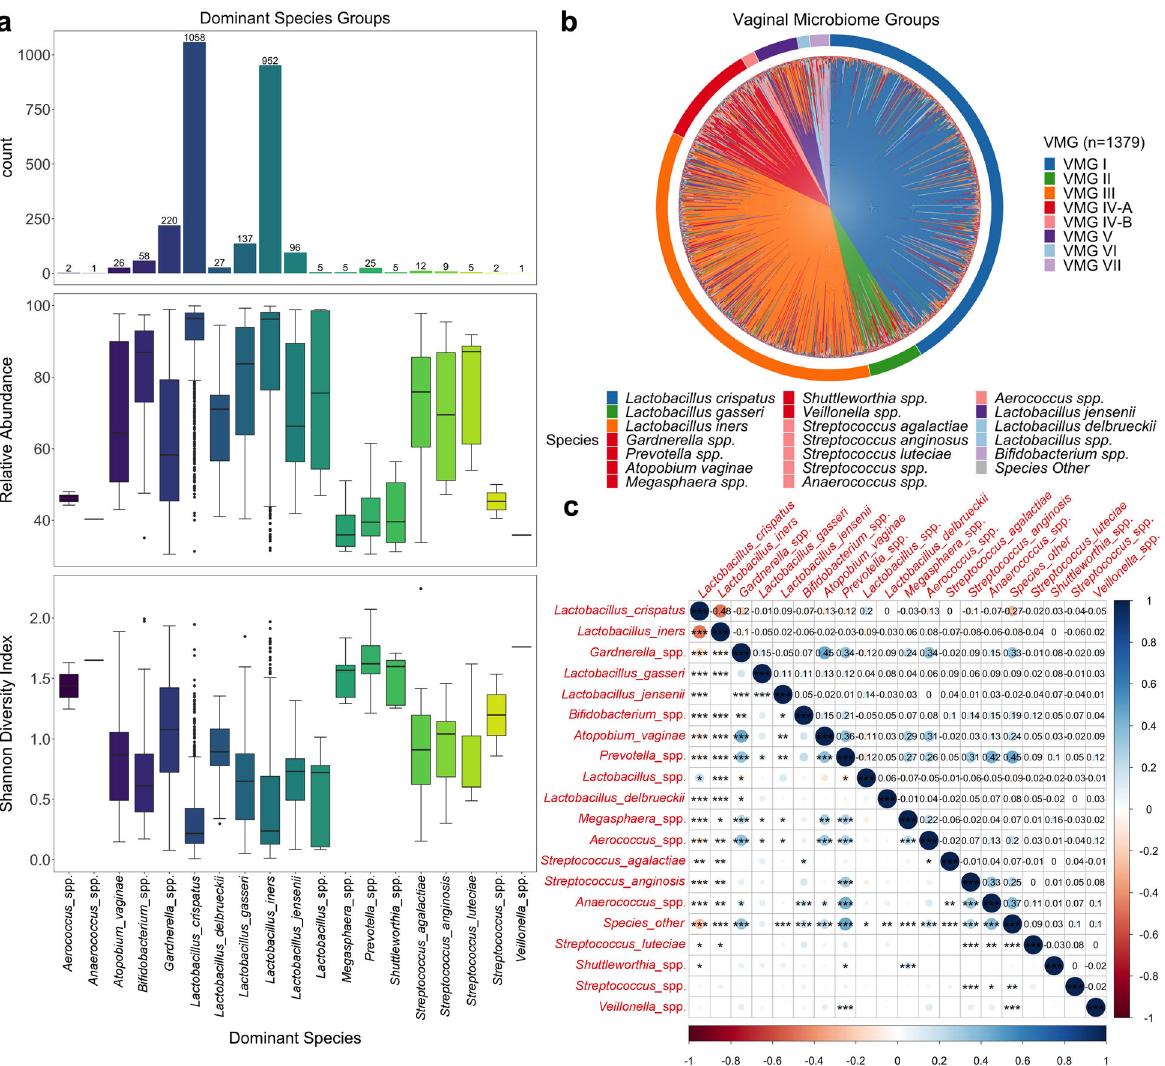
Fig. 1 Vaginal microbiome composition and structure. a Bar chart displaying number of samples within each dominant species group. Box plots show relative abundance of species and Shannon diversity index of each dominant species group with bounds of the box representing the fi rst and third quartiles, the center line representing the median and whiskers as min-to-max values. b Microbiome pro fi les of women with outcome data classi fi ed by vaginal microbiome groups (VMG). Color of species denotes the VMG group classi fi cation with VMG I ( L. crispatus dominated, blue), II ( L. gasseri dominated, green), III ( L. iners dominated, orange), IV-A (bacterial vaginosis associated, red), IV-B (non-BV taxa, pink), V ( L. jensenii dominated, purple), VI (Other Lactobacillus , light blue), and VII ( Bi fi dobacterium dominated, light purple). c Correlation plot for dominant species showing correlation strength (circles), relationship (positive, blue; negative, red) and signi fi cance (***, p < 0.001; **, p < 0.01; *, p <